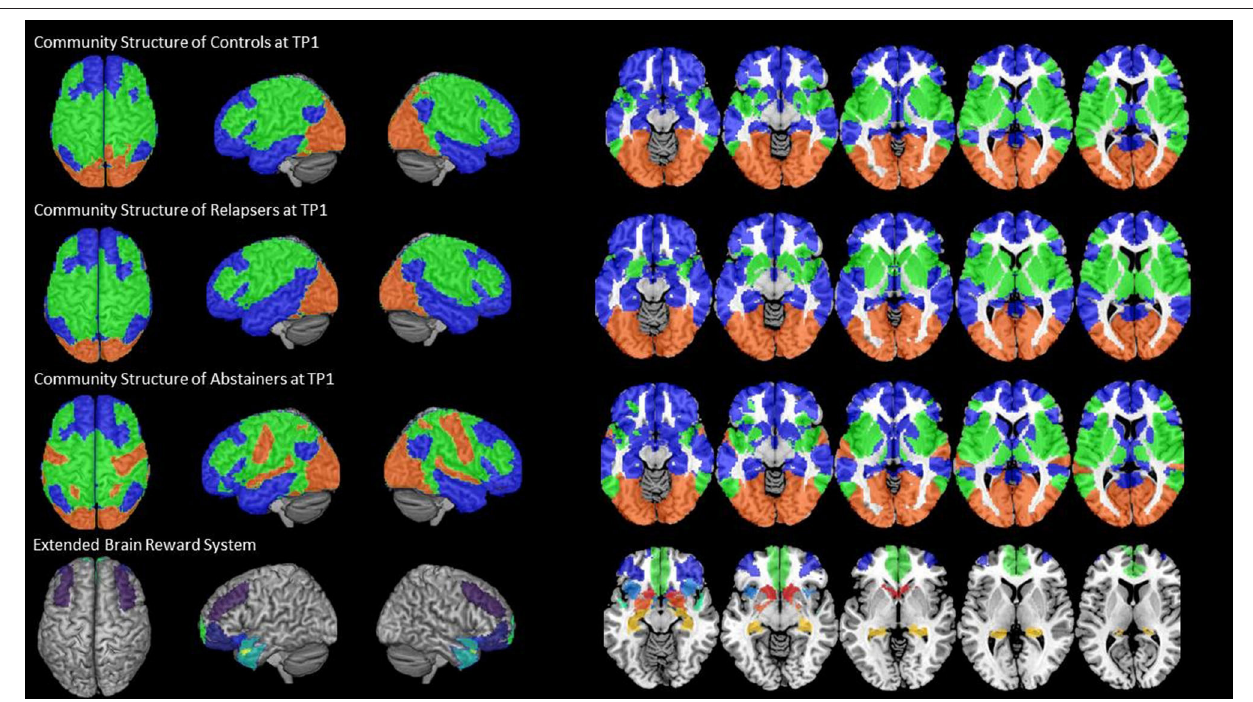
FIGURE 2 | The three-community configuration and the location of the eBRS in relation to the communities. The three-community configuration of the controls (CON), the relapsers (REL), and abstainers (ABS) found at baseline are shown in the first, respectively, second and third row, the location of the eBRS within the brain is and in relation to the three communities is shown in the bottom row. The majority of the eBRS regions were allocated within community 1 (blue color).